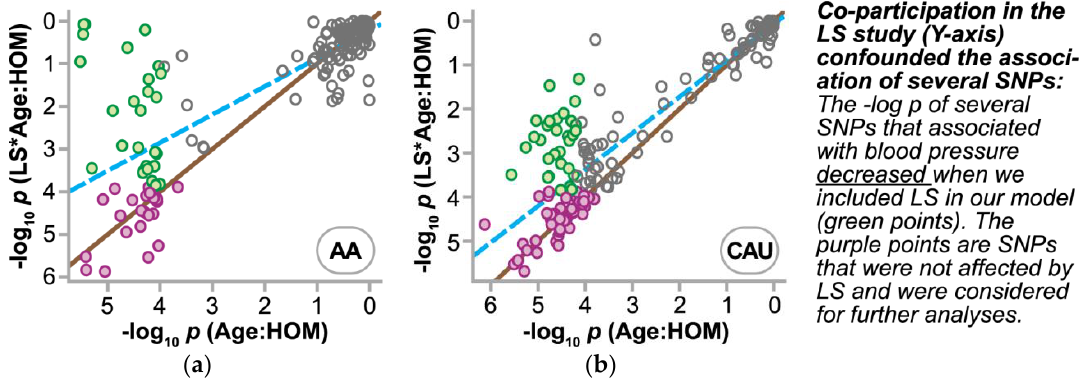
Figure 3. Lifestyle co-participation correction on SNP discovery. The effect of including a lifestyle co-participation variable (LS) in the model for ΔSBP is represented by a scatter plot of the p values of the Age:HOM interaction term with or without the LS variable on either the y - or x -axis, respectively, in the AA ( a ) or CAU ( b ) cohort. Regression analysis (dashed line) indicates the overall effect of the correction by how far it deviates from no change (solid line). Individual SNPs that passed the discovery cutoff of p < 1 × 10 −4 with the LS correction or SNPs that were confounded by LS participation and excluded from additional analyses are indicated by either magenta- or green-filled points, respectively. Open points represent additional SNPs with no association to ΔSBP ( p > 1 × 10 −4 ). HOM: homozygous status of the SNP.